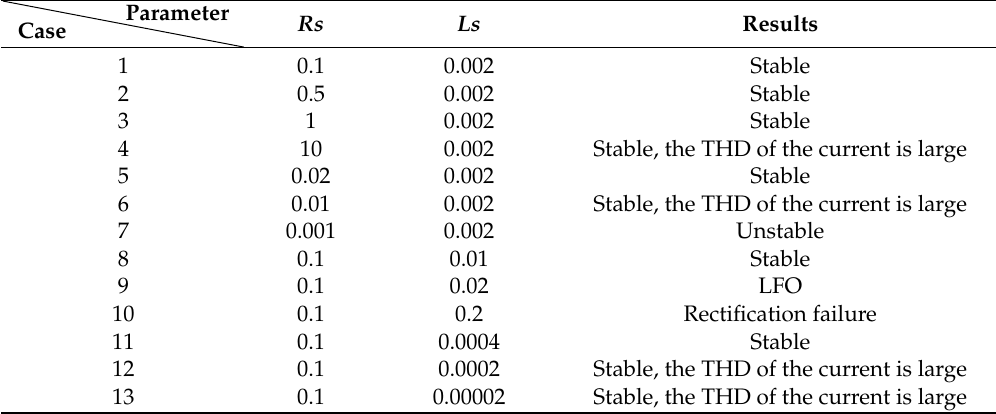
Table 4. Parameter effect based on PI.